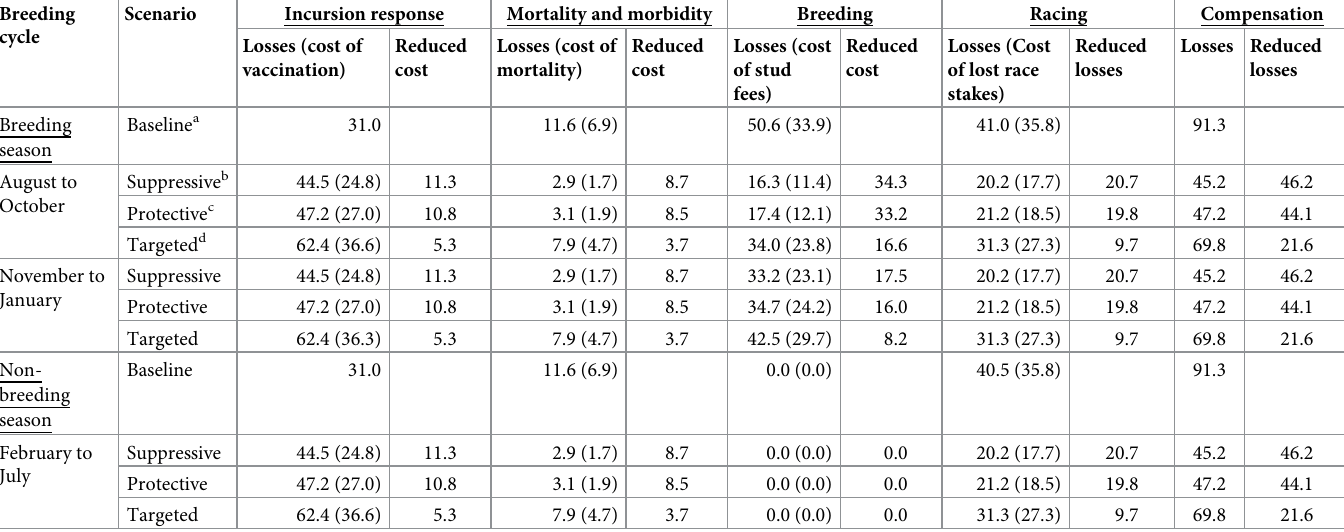
Table 5. The estimated losses and reduced losses to parameters within the economic model; incursion response, horse mortality and morbidity, breeding income, racing income and compensation. The duration of the outbreak, number of infected and vaccinated properties determined through simulation modelling. Breeding cycle